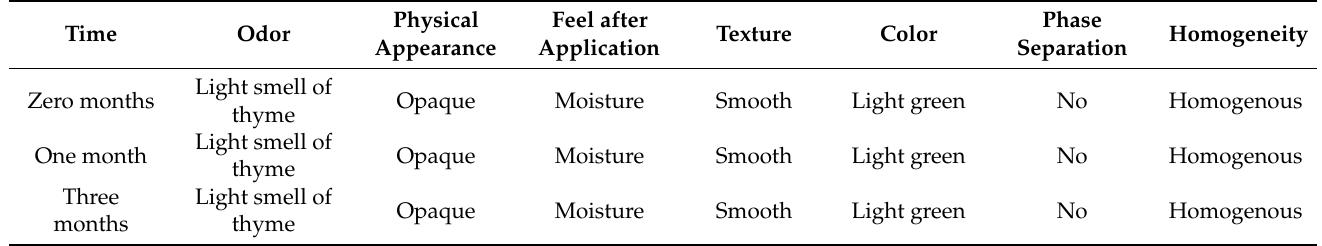
Table 3. Physicochemical evaluations for the F2 formula at zero time, one month, and after